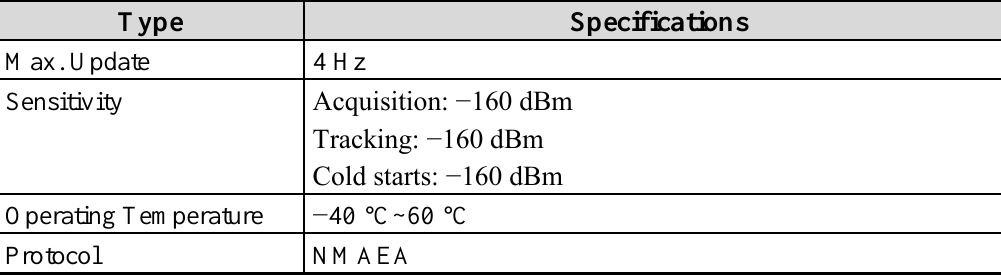
Table 3. Hardware Specifications of the GPS Module.